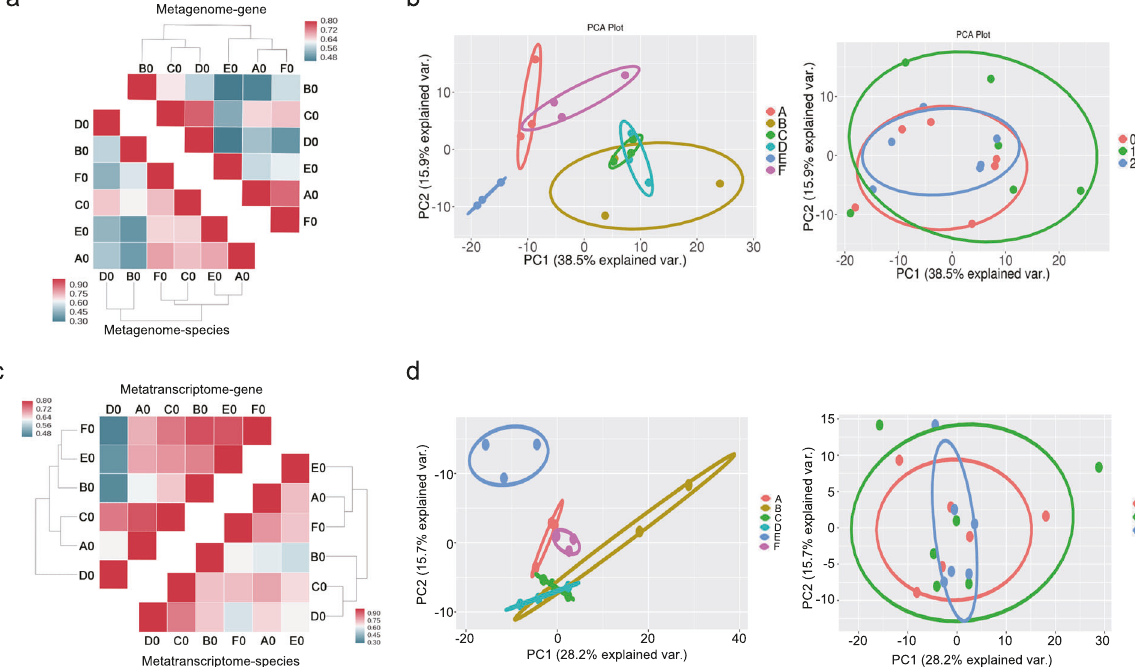
Fig. 4 The response of human gut microbiome to L. casei Zhang was limited and heterogeneous. a Hierarchical clustering heatmap of sample classi fi cation by Pearson correlation coef fi cient of genes (upper right) and species (lower left) abundance prior to L. casei Zhang ingestion. b PCA analysis of meta-genomic species abundance in all 18 samples by individual classi fi cation (left) and temporal classi fi cation (right). c Hierarchical clustering heatmap of sample classi fi cation by Pearson correlation coef fi cients of species (lower right) and gene (upper left) abundance prior to L. casei Zhang ingestion. d PCA analysis of meta-transcriptome species abundance in all 18 samples by individual classi fi cation (left) and by temporal classi fi cation